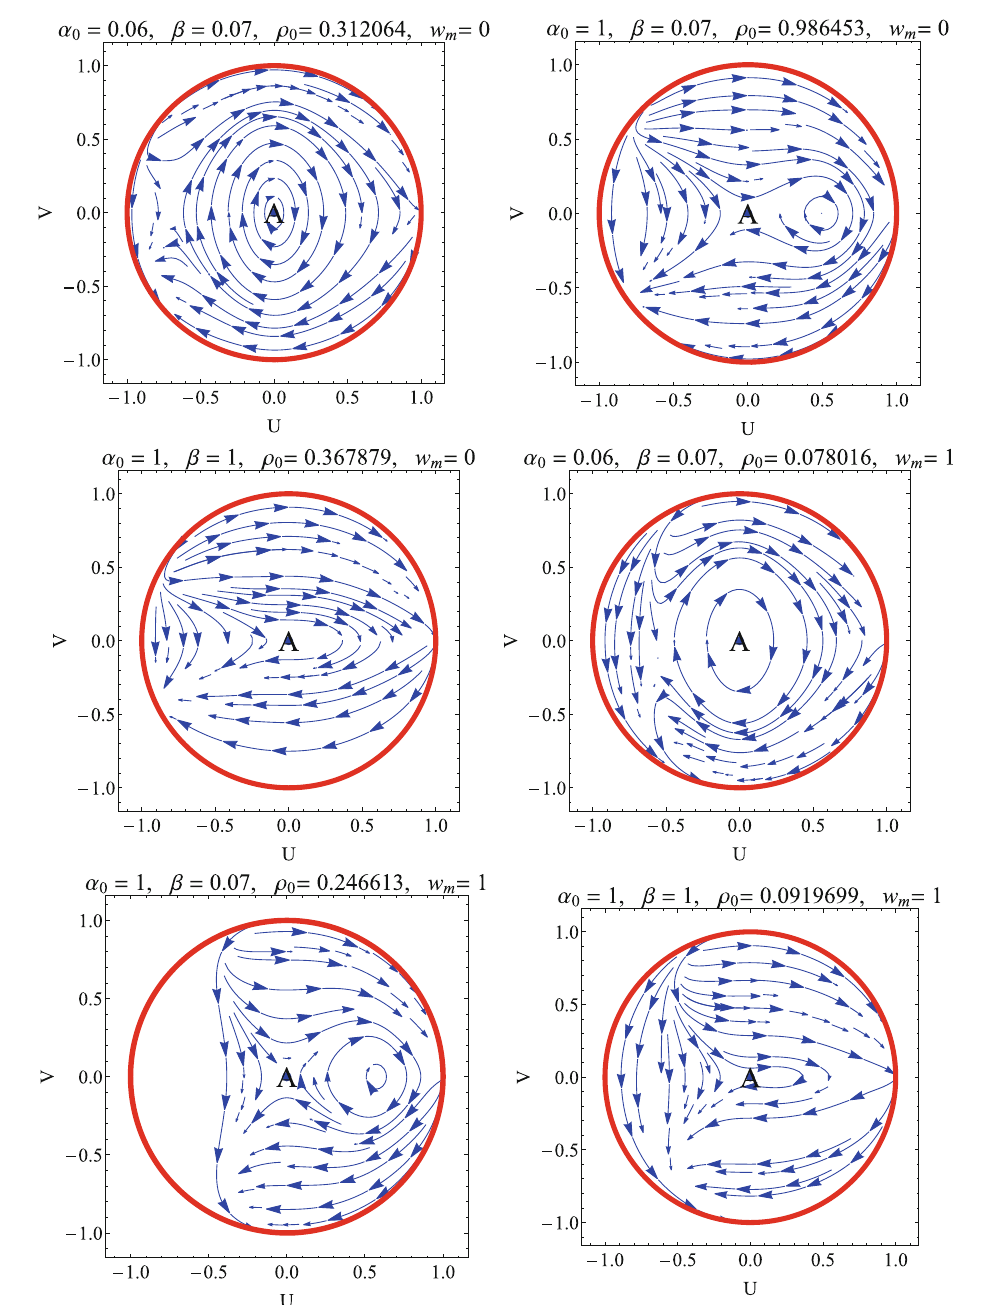
Fig. 9 Dynamics of system (75)–(76) for the for some values of b 0 and β , and for a) dust w m = 0 and b) for stiff matter w m = 1. We have assumed (cid:8) (cid:7) e − b 0 2 b 2 0 + 2 b 0 β + b 0 − β − 1 ρ ( 3 w + 1 ) = m 0 6 6 ( b 0 + β) 2